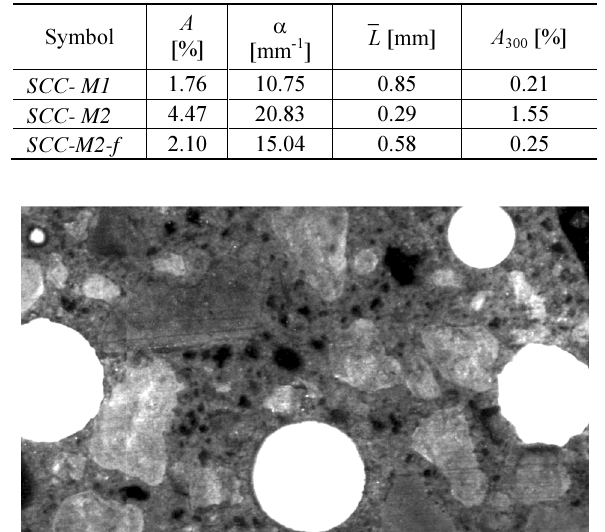
Table 8. The test results for the porosity characteristics of hardened concrete